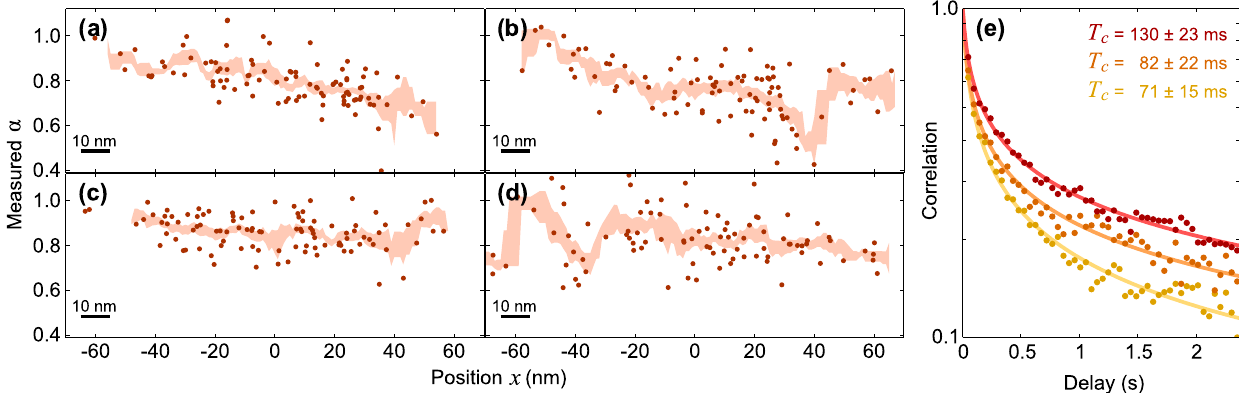
FIG. 2 (color online). 1D profiles of α . Each circle represents a single measurement of α versus x using a 100-ms set of data. The shaded regions represent the running mean and standard error with 10-nm resolution (thick black bar). Each profile is recorded minutes apart to allow the particle time to diffuse to different regions of the cell with qualitatively different spatial structures. The particle confinement is greatest where α is lowest, such as the dip about 40 nm in (b), and the particle movement is most free when α is highest, such as the peak at − 55 nm in (d). To verify that the changes in α are spatial, correlations between sequential measurements of α ð x Þ are analyzed for three sets of data in (e). The circles are experimentally determined correlations between a series of measurements, which are well fitted by the predicted relation (lines) explained in the Supplemental Material, Sec. S1 [38]. By fitting data to this theory, the characteristic time T c for the particle to diffuse into uncorrelated regions of the cell can be determined. Note that the decay in correlation restricts the duration over which α ð x Þ profiles can be constructed. Although the characteristic times found here are in the range of 0.1 s, correlations are found to persist for sufficient time to construct the 10-s α ð x Þ profiles shown